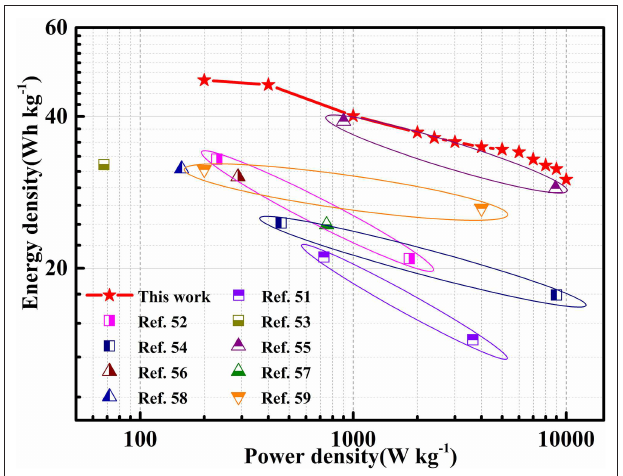
FIGURE 7 | Comparison of energy densities among as-constructed Ni 1.64 Co 2.40 S 4 /rGO//AC with recently reported asymmetric supercapacitors.